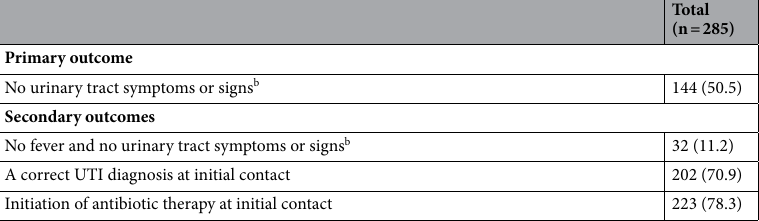
Among all the cases, 82 (28.8%) and 169 (59.3%) were cases of complicated UTI and pyelonephritis, respectively. The most common pathogen was Escherichia coli (n = 211, 74.0%), followed by Klebsiella species (n = 27, 9.5%). For the primary outcome, any urinary tract symptom or sign was absent at initial presentation in 144 (50.5%) patients (Table 2). For the secondary outcomes, the proportion of patients without fever and any urinary tract symptoms or signs was 11.2%, and the proportion of patients with a correct UTI diagnosis at initial presentation was 70.9%. Antibiotic therapy was started at initial contact for any reason in 223 (78.3%). The most common initial diagnosis at first contact was UTI or urosepsis (n = 202, 70.9%), followed by unspecified fever (n = 27, 9.5%) and pneumonia (n = 14, 4.9%). In the multivariable analysis, older age (OR 2.16; 95% CI 1.22–3.83), male sex (OR 1.85; 95% CI 1.09–3.13), dementia (OR 2.19; 95% CI 1.11–4.30), and early visit from symptom onset (OR 1.77; 95% CI 1.07–0.2.95) were predictive factors for atypical presentation in UTI patients (Table 3). Patients without urinary tract symptoms or signs were less likely to be diagnosed with UTI correctly at presentation (OR 0.30; 95% CI 0.17–0.51) and to